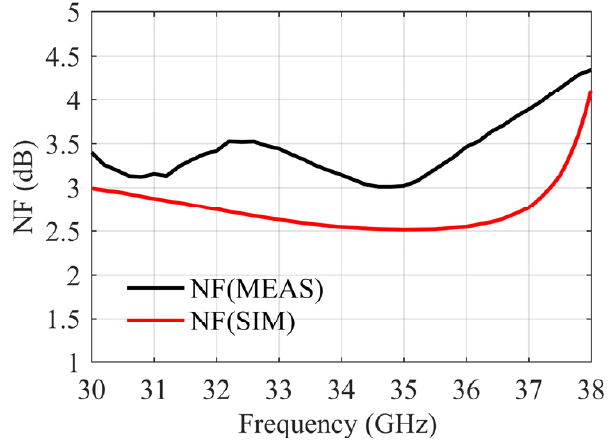
Figure 22. Noise figure results.